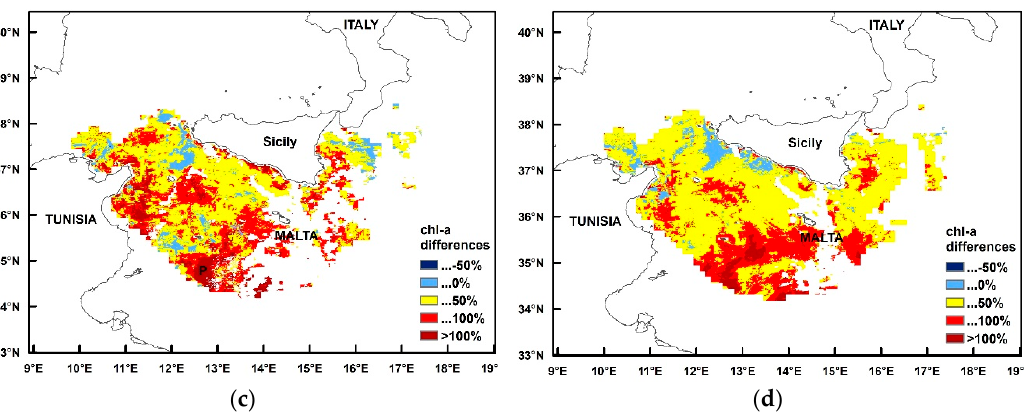
Figure 5. ( a ) The study area together with the mean 1998–2016 chlorophyll-a concentration for November and the medicane’s track. Day and hour refer to the white dots while the red dot denotes the minimum pressure; ( b ) SST differences between 4 and 10 November 2014; ( c ) Chlorophyll percentage differences between the maximum concentrations of 5 days after the event (9–13 November 2014) and 5 days before (1–5 November 2014), P denotes the area of large chlorophyll increase referred in the text; ( d ) Same as (c) for the 5 days after the event and 1998–2016 November climatology.